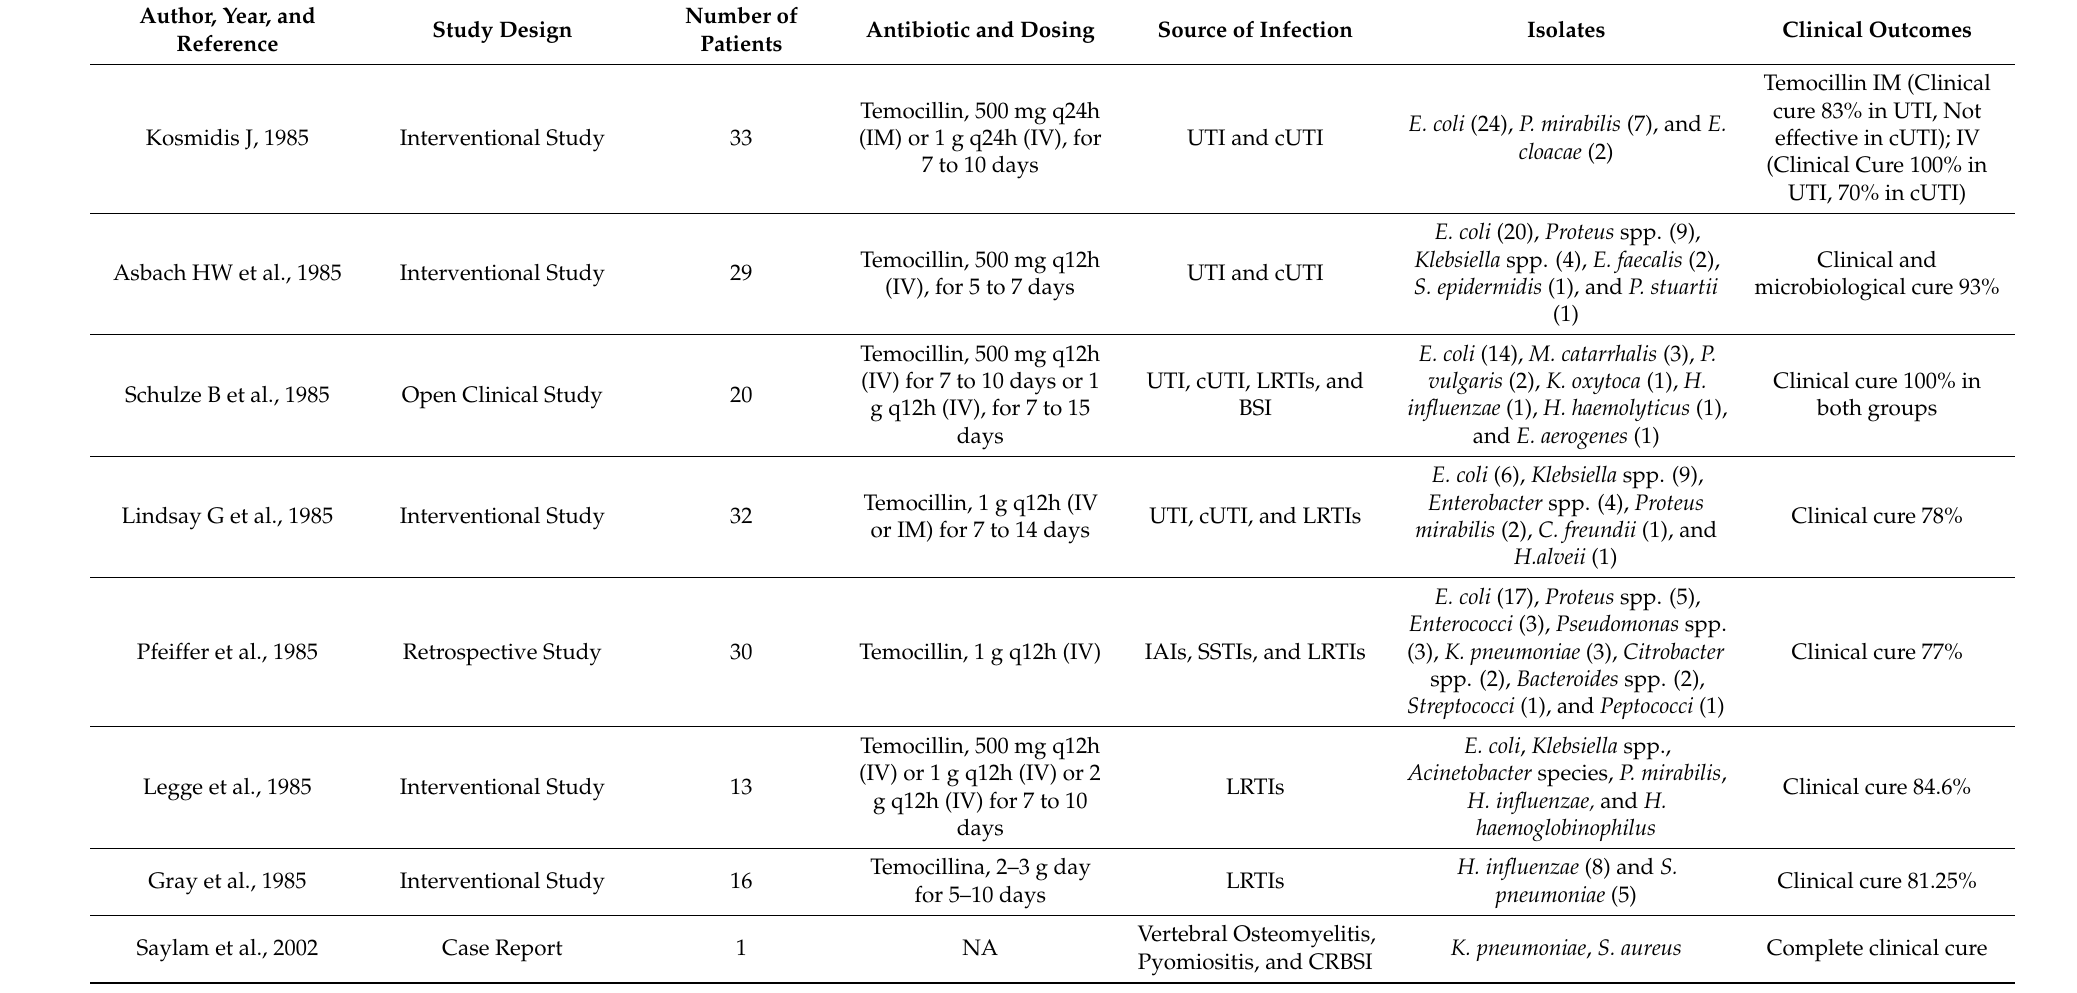
Table 1. Clinical studies and Clinical experiences with Temocillin in Infectious